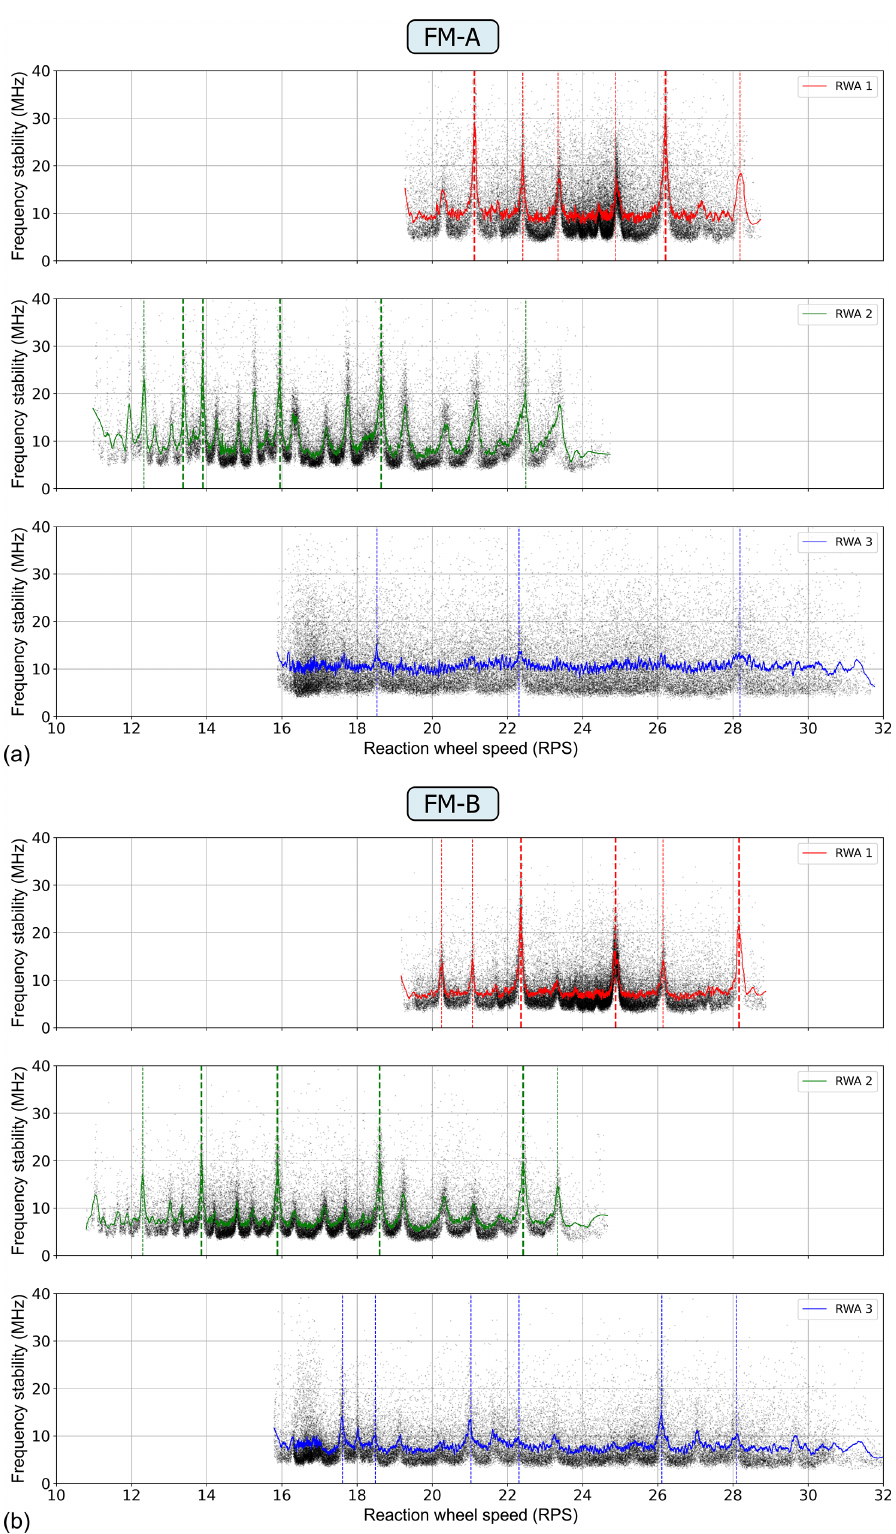
Figure 8. Correlation between the laser frequency stability and the speeds of the three active reaction wheels: the plots in panel (a) are based on data from the FM-A laser for the period between 13 and 20 May 2019, while the plots in panel (b) show the correlation for the FM-B laser in the period between 14 and 21 October 2019. The colored lines result from a Savitzky–Golay smoothing with a window size of 201 and polynomial order of